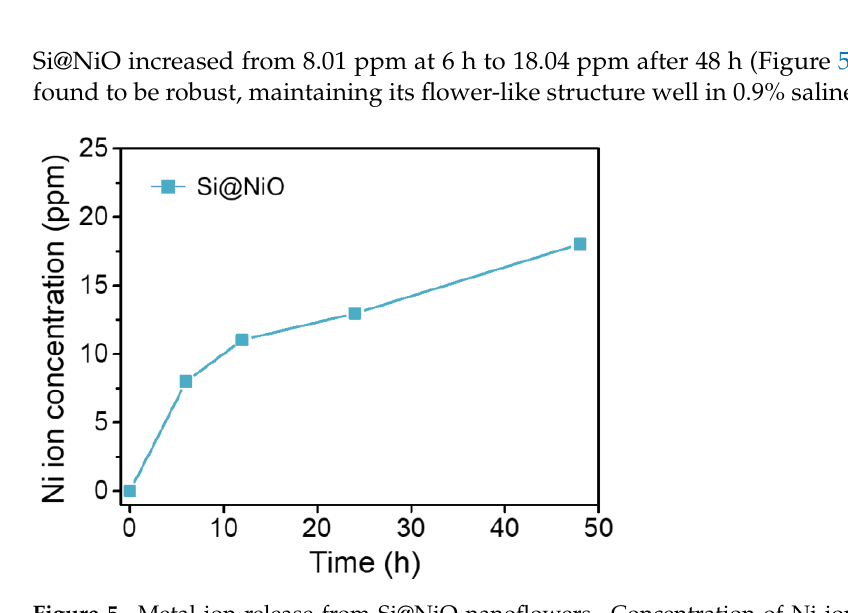
7 of 12 Figure 4. Electrochemical characterization. CV curves of Si NP and Si@NiO acquired in PBS con- taining 0.1 M AA; scan rate: 100 mVs −1 .